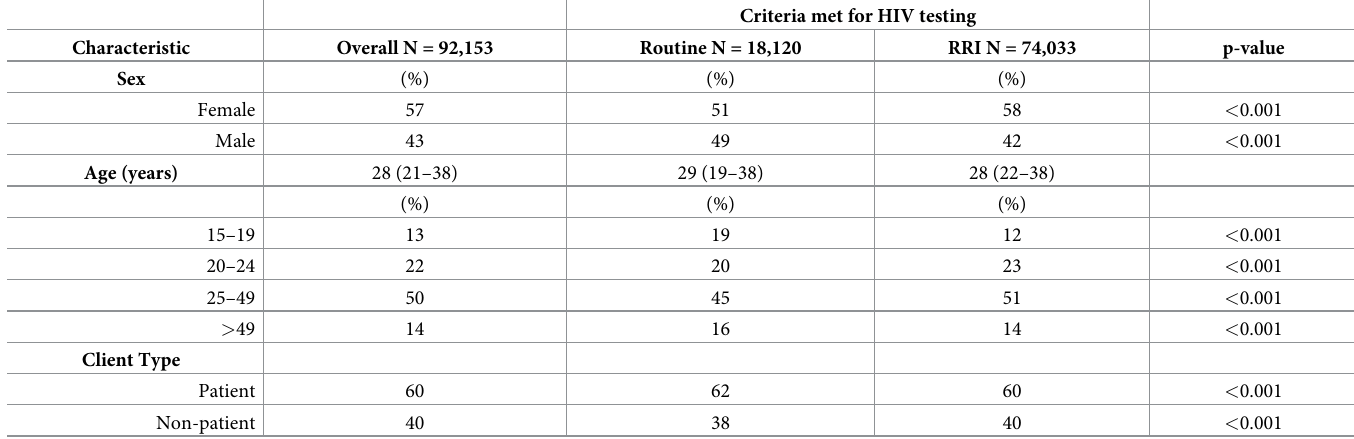
Table 1. Characteristics of persons tested for HIV at selected facilities in Siaya, Kisumu and Homa Bay Counties, Kenya.